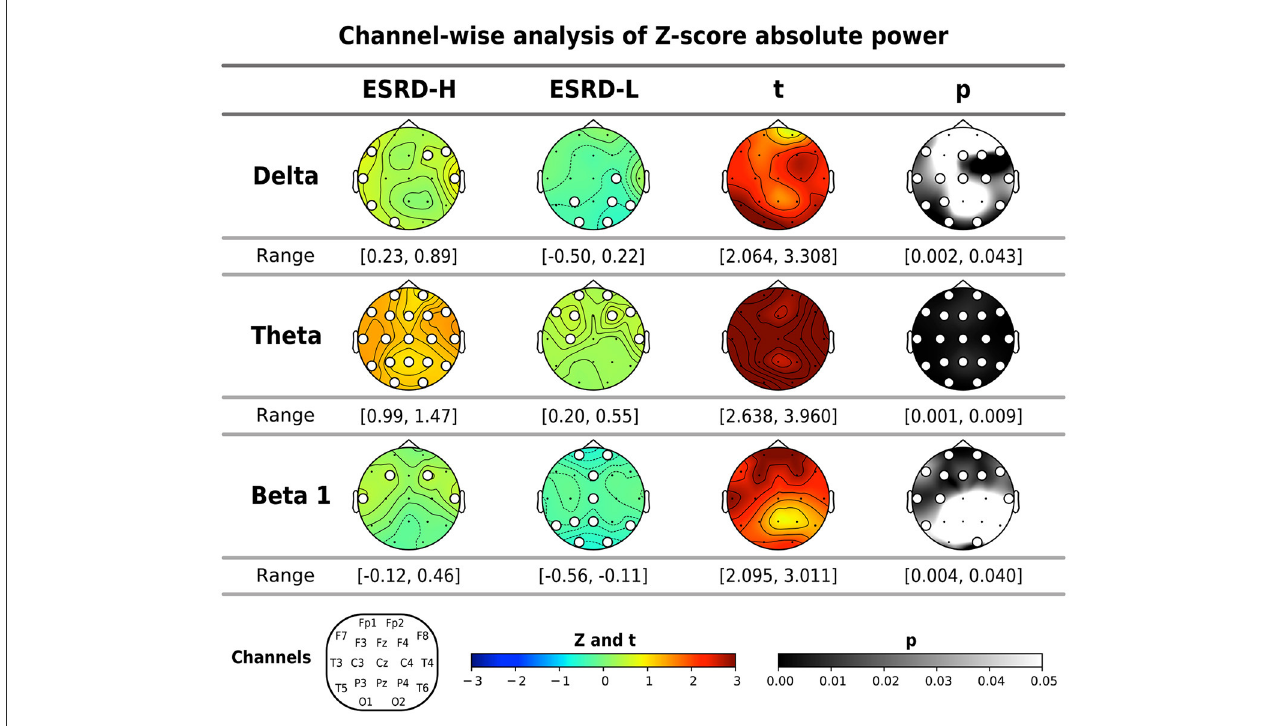
FIGURE1 The significant band powers (delta, theta, and beta 1) according to the global mean analysis of the Z-score FFT absolute powers were determined through channel-wise comparisons between subject groups and comparisons to zero (mean of normative data) by using permutation-based t -tests and one-sample permutation tests. The white dots indicate significant channels in the map. All values are represented by color bars and described in the closed interval, except the t - and p -values, which indicate significant values.